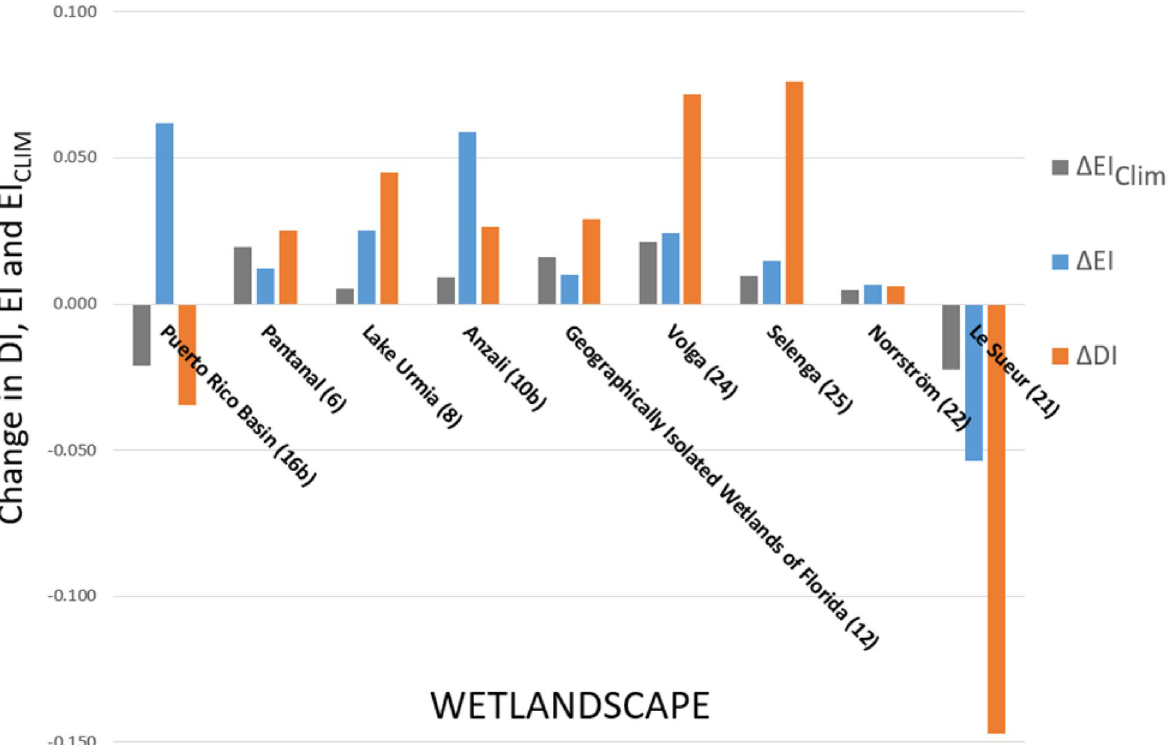
Figure 5. Change in evaporative and dryness index for wetlandscapes with available discharge data. Change in the evaporative indices (ΔEI) are represented as blue bars and as grey bars for ΔEI Clim . Change in dryness index (ΔDI) is shown as orange bars. The changes in evaporative and dryness indices corresponds to the time period of the discharge data for these wetlandscapes (Table